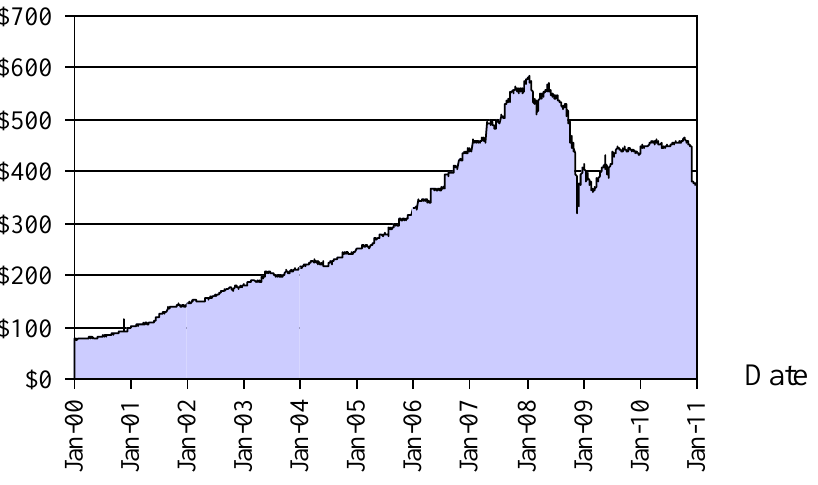
Figure 1. Market Capitalization of Investment Grade Commercial Mortgage-backed Securities (CMBS) from 3 January 2000, to 3 January 2011. Source: Barclays Capital’s CMBS Index.